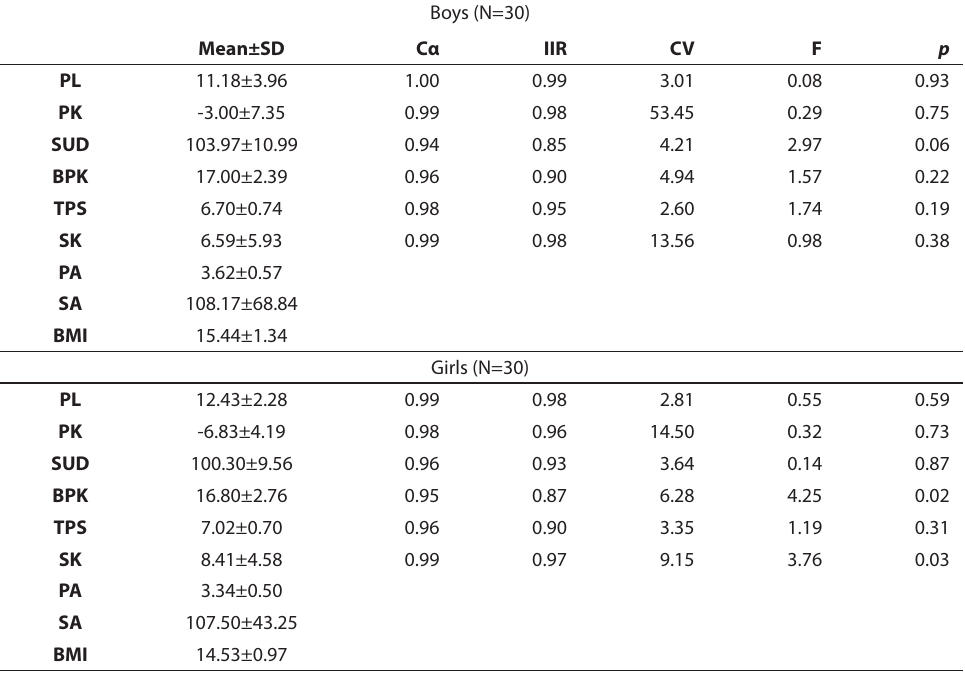
TABLE 1 Results of the reliability test and the t-test for independent samples in motor tests, morphological features and physical activity (Mean±SD: mean ± standard deviation; Cα: Cronbach alpha, IIR: infinite impulse response; CV: coefficient of variation; F: ANOVA test value, p: level of significance) Boys (N=30)